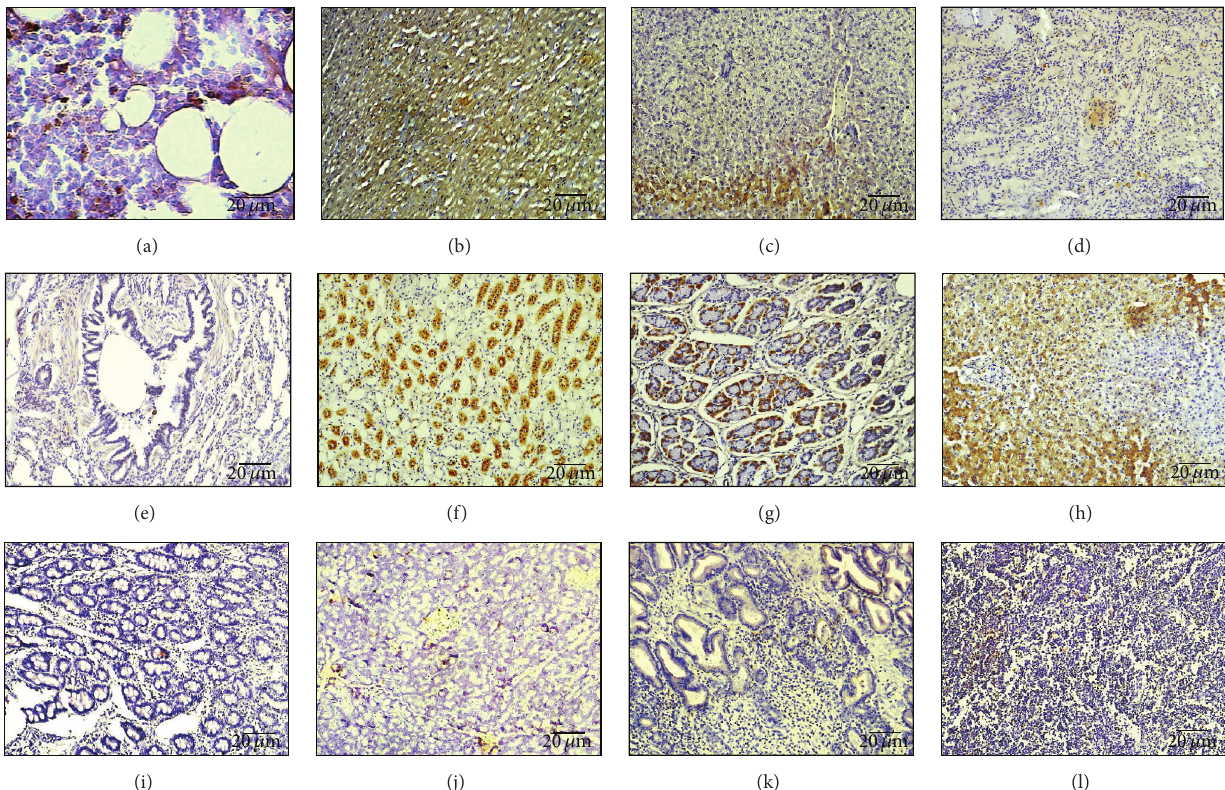
Figure 3: The distribution of MSCs with intra-arterial infusion in femoral head and vital organs. Immunohistochemical staining of BrdU- positive MSCs in different tissues at eight weeks after transplantation was observed under a light microscope. (a) Femoral head. (b) Heart; (c) liver; (d) spleen; (e) lung; (f) kidney; (g) stomach; (h) gallbladder; (i) small bowel; (j) pancreas; (k) prostate; (l) testicle. Scale bar 20 𝜇 m . Particularly, BrdU strongly positive MSCs were significantly located in the tissues of the kidney, gallbladder, and liver.